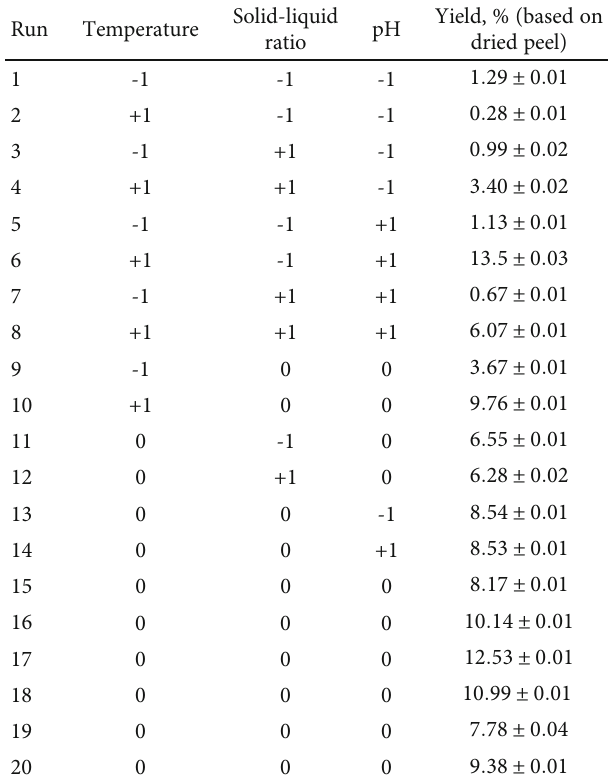
Table 1: Yield based on the central composite design (using coded values) for the microwave-assisted extraction of pectin from “ Saba ” banana peel waste. Run